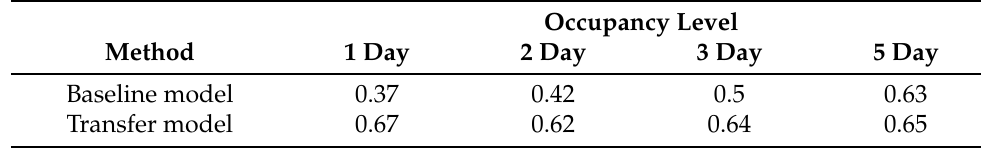
Table 8. Occupancy level prediction performance analysis as the MCC score with different amounts of data for training of baseline and transfer model.